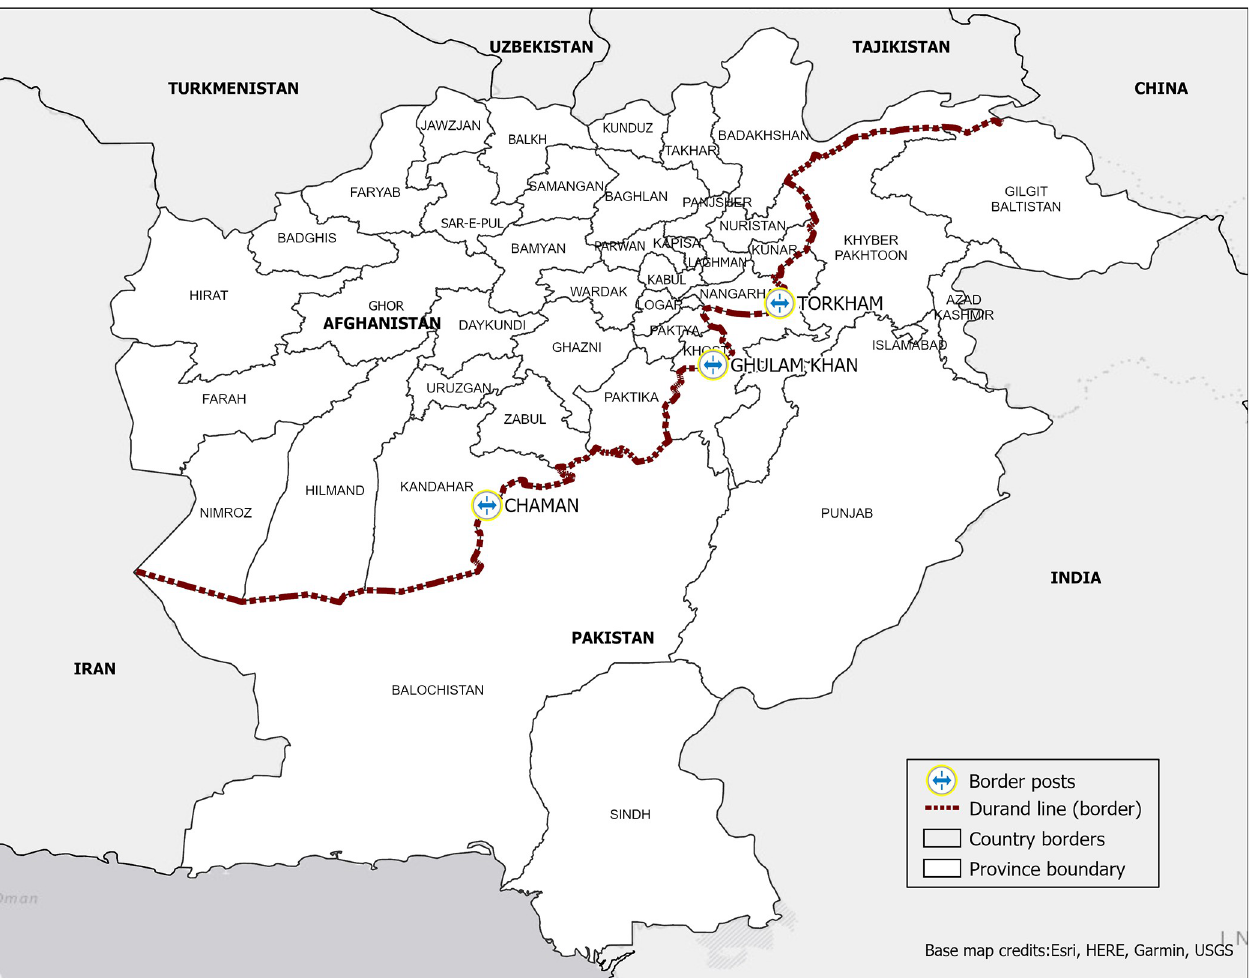
Fig 1. Official border crossings (border posts) between Afghanistan and Pakistan. Base map service credits- Esri, HERE, Garmin, (c) OpenStreetMap contributors, and the GIS user community [8].